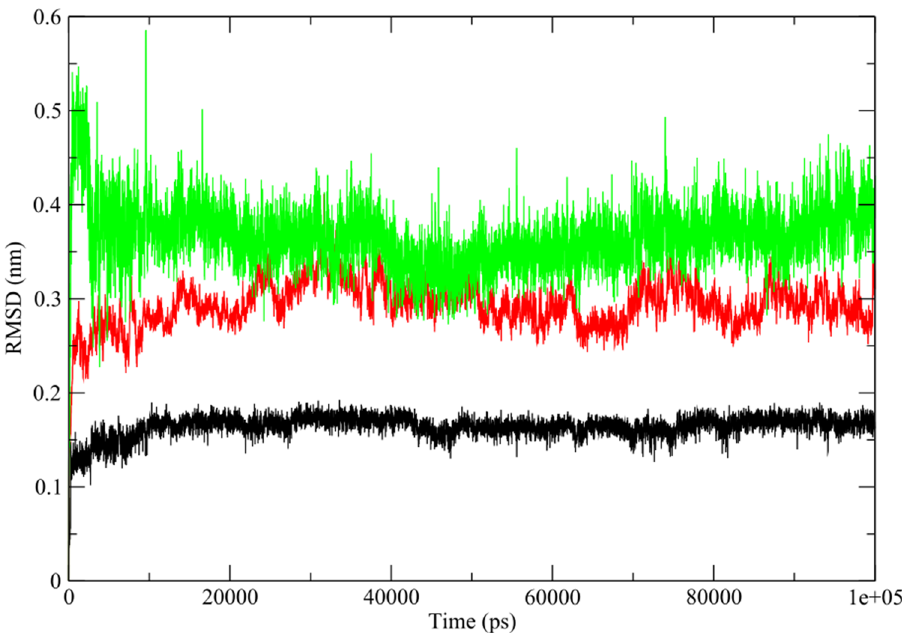
Figure 8. RMSD plots of target proteins (CDK2)—ligand (homonataloin) complex over 100 ns MD simulation.